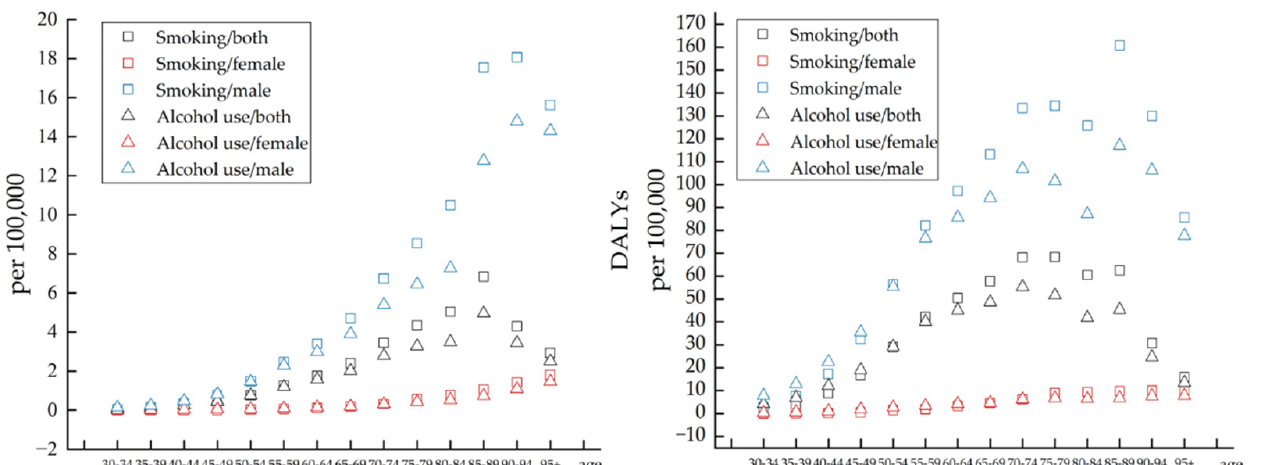
Figure 3. The variation trends of ASDR and age-standardized DALY rate of three risk factors in different genders over 30 years.